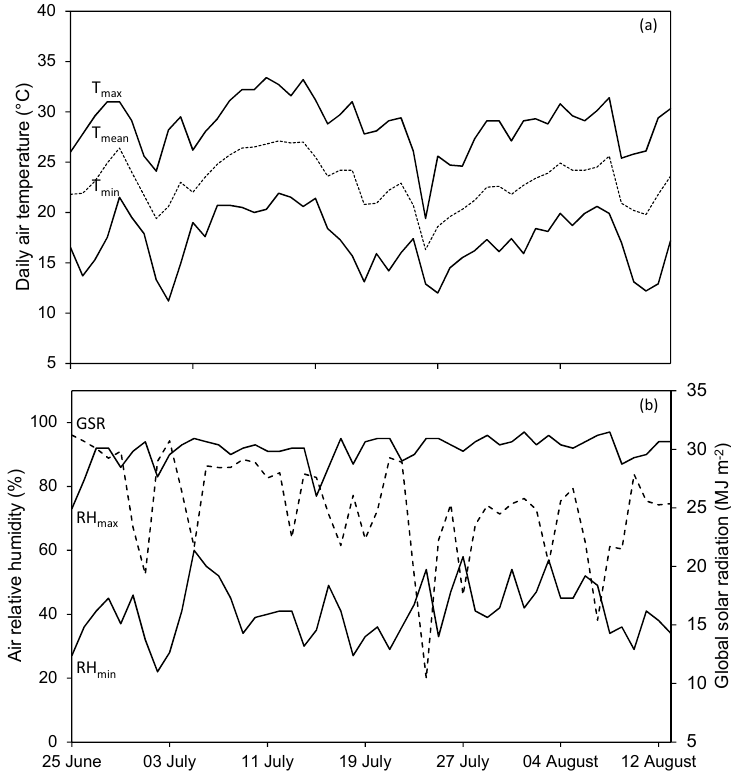
Figure 1. Weather conditions during the experimental season: ( a ) daily air temperature and ( b ) air relative humidity (RH) and global solar radiation